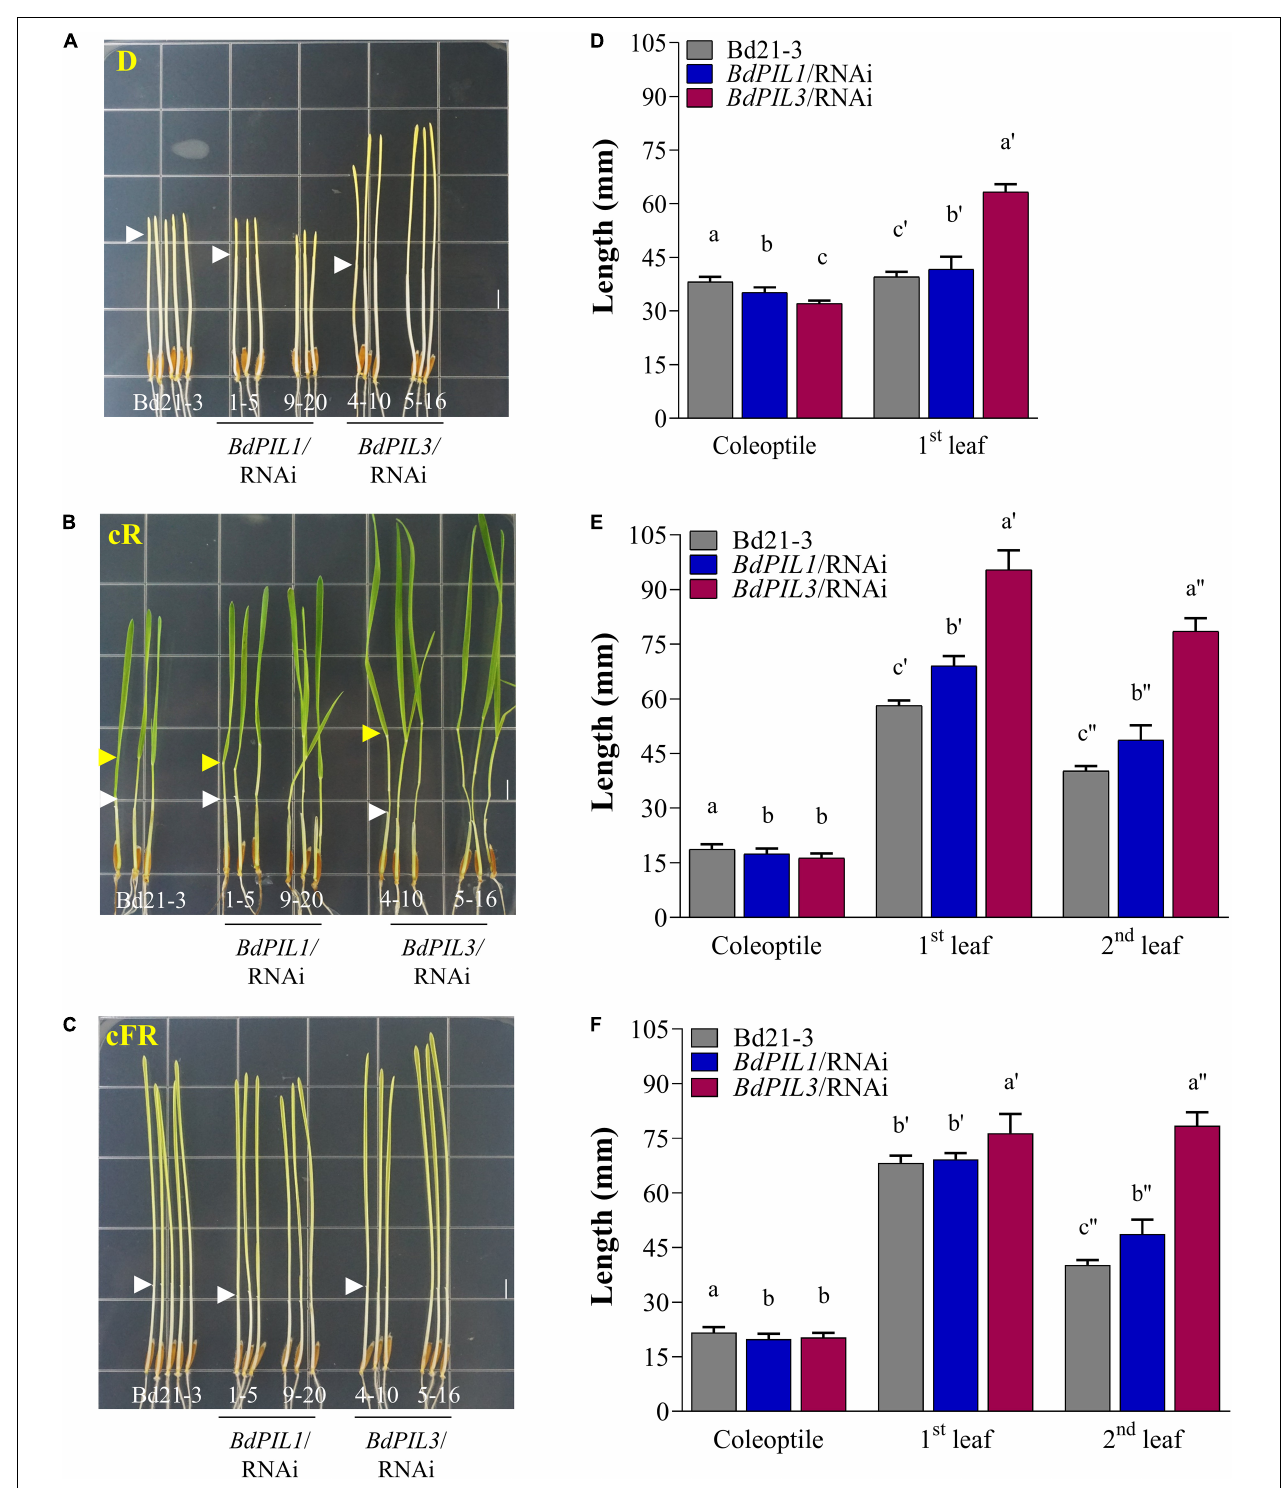
FIGURE 2 | Photoresponses of transgenic Brachypodium plants harboring RNAi constructs of BdPIL1 and BdPIL3 to red and far-red light. (A–C) Representative seedlings grown in the dark (D), under continuous red (cR, 20 µ mol · m − 2 · s − 1 ), or continuous far-red (cFR, 20 µ mol · m − 2 · s − 1 ) light. White and yellow arrowheads indicate the ends of coleoptiles and the lamina joints of second leaves, respectively. Scale bar, 5 mm. (D–F) The lengths of coleoptile, first and second leaves of 6-day-old seedlings measured using ImageJ program. Data represent the means ± SD ( n ≥ 30). Different letters represent significantly different means ( P < 0.05, Duncan’s multiple range